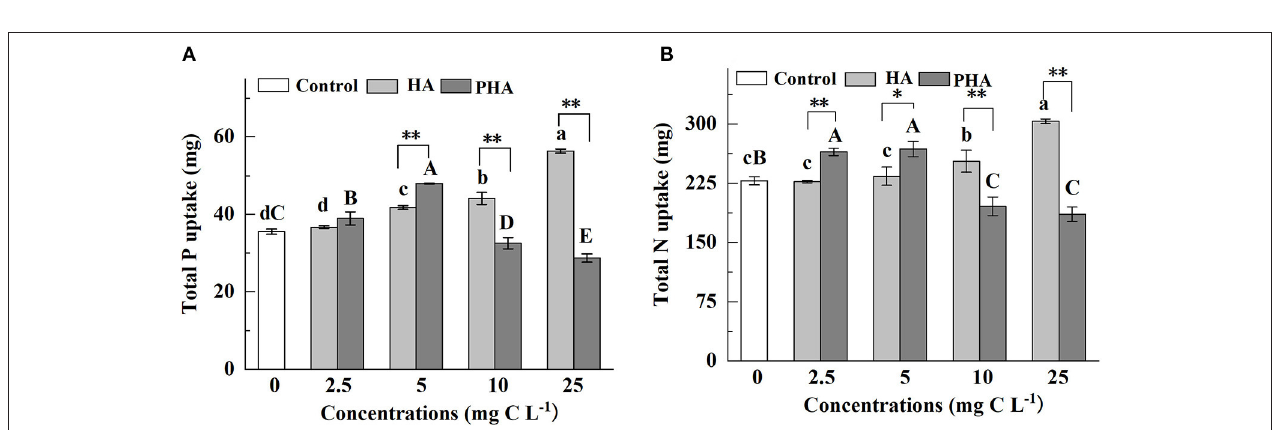
FIGURE 2 | Effects of 2.5–25mg C L − 1 of HA and PHA on the (A) total P uptake and (B) N uptake. Error bars represent standard deviations ( n = 3). Different lowercase letters above the column indicate significant differences between HA and control treatments, while different capital letters above the column indicate significant differences between PHA and control treatments at P < 0.05, as determined by the LSD test. Significant differences between HA and PHA treatments at equivalent carbon concentrations were compared with two independent sample t -tests, * P < 0.05; ** P < 0.01.